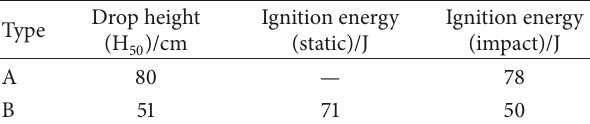
needs high temperature (hundreds of degrees centigrade) to Table 2: Results of ignition energy under static and dynamic